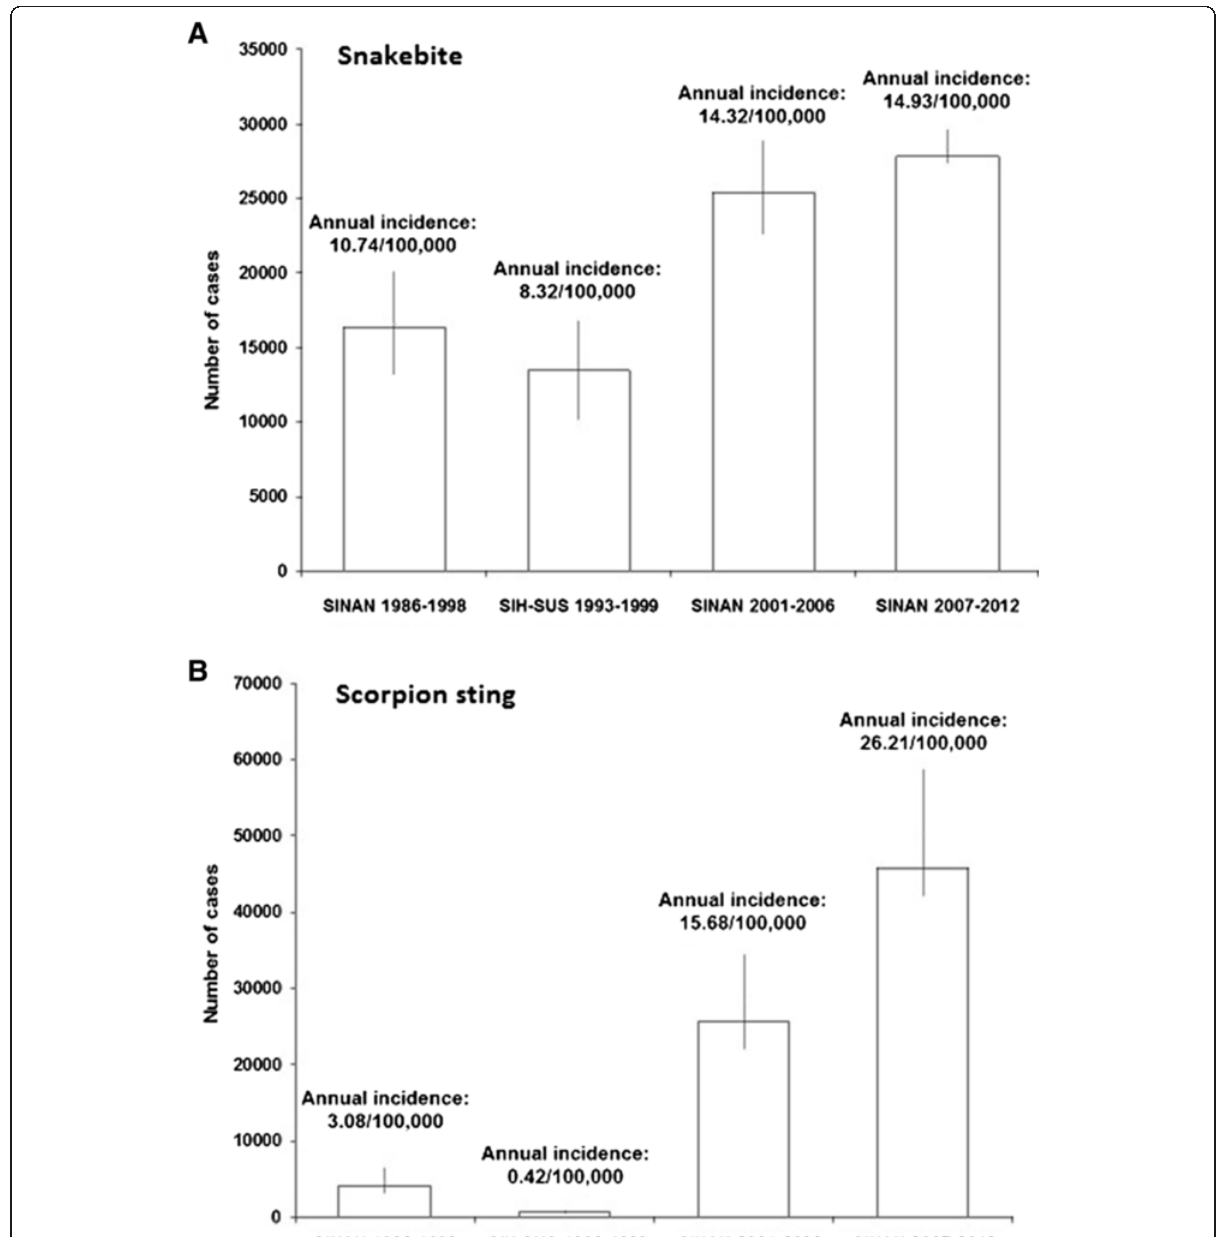
Fig. 11 Notifications of snakebite and scorpion stings in Brazil at various periods according to the Brazilian Notifiable Diseases Information System (SINAN). ( A ) Snakebite notification. ( B ) Scorpion sting notification. SUS: Brazil ’ s Unified Health System. SIH: Hospital Information